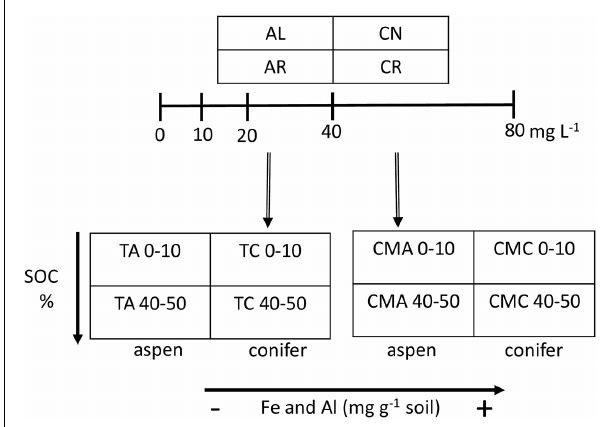
FIGURE 1 | Experimental design of the sorption experiment. Leachates from four plant substrates – aspen leaves (AL), aspen roots (AR), fir needles (CN), and fir roots (CR) - were added to aspen (A) and conifer (C) soils at four concentrations plus blank (0, 10, 20, 40, and 80 mg L − 1 ). The two depths (0–10 and 40–50 cm) represented differences in native SOC concentration, and the T (for TWDEF) and CM sites represented differences in oxyhydroxide concentration. All measurements were done in triplicate for 0, 10, and 80 mg L − 1 treatments, and in duplicate for 20 and 40 mg L − 1 treatments.